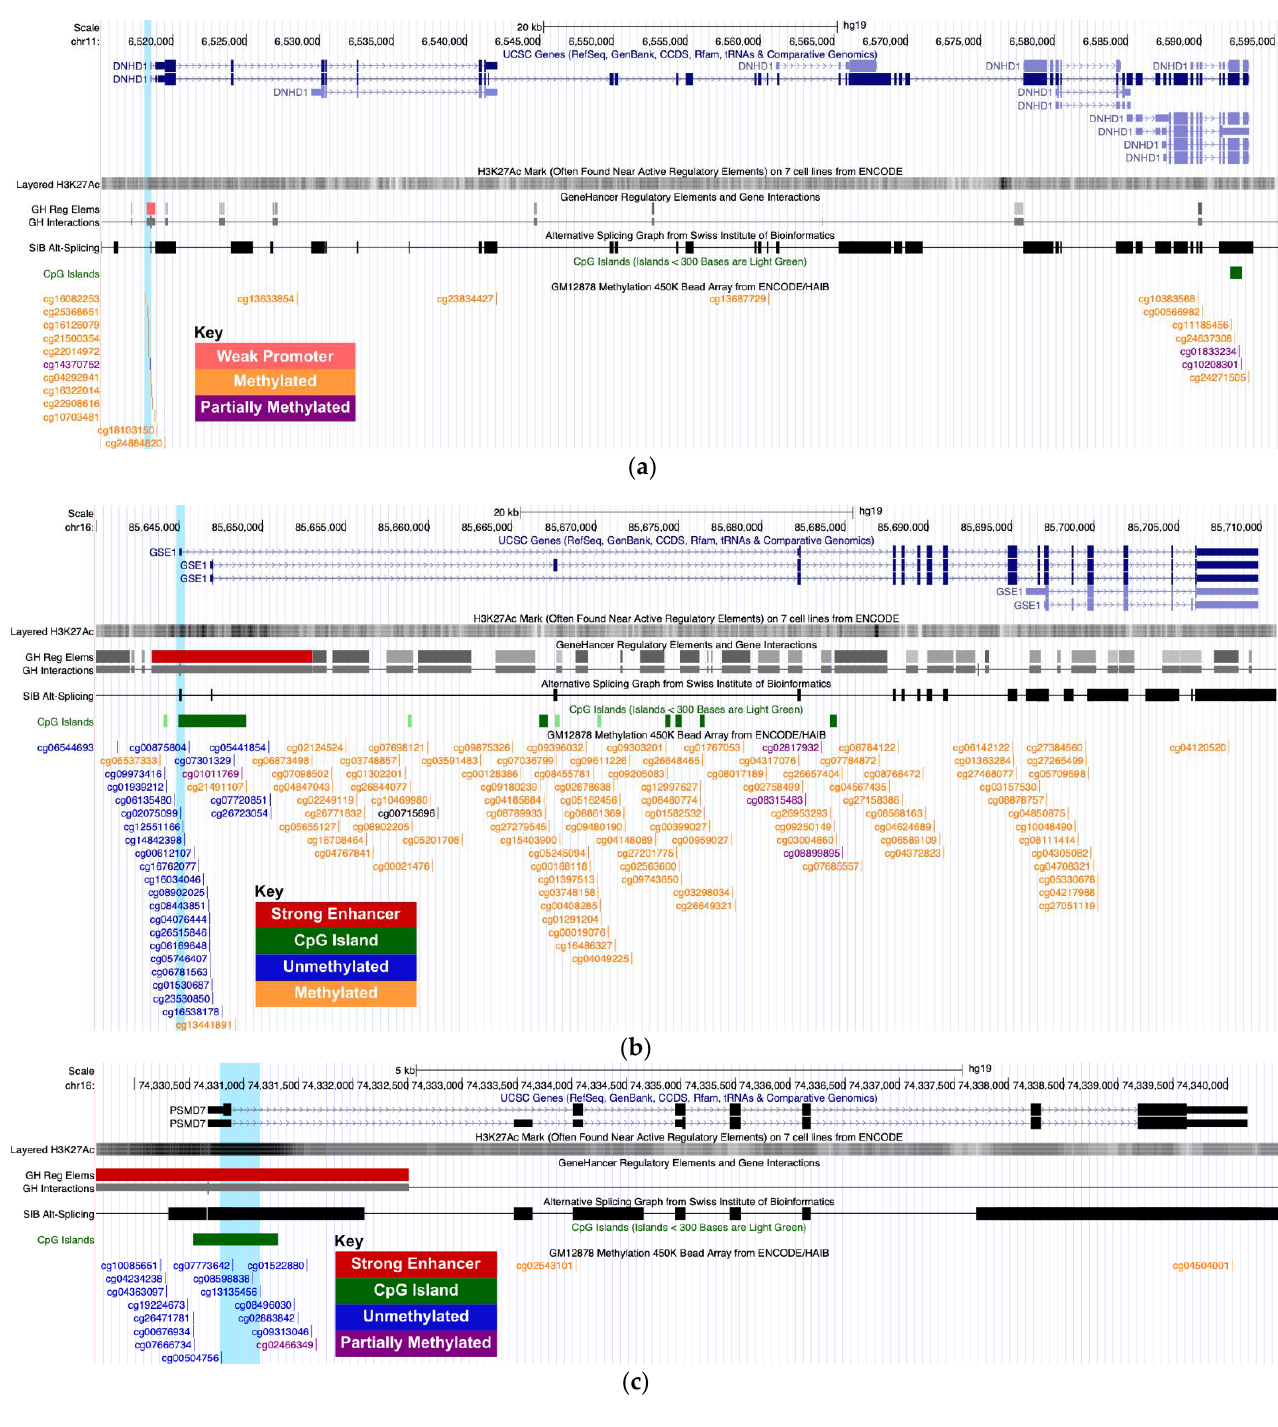
Figure 1. Biological features near ( a ) DNHD1 , ( b ) GSE1 , and ( c ) PSMD7 from ENCODE. Highlighted fragments correspond to the DMR position. Table 2. Statistically significant DMRs by LV trait.